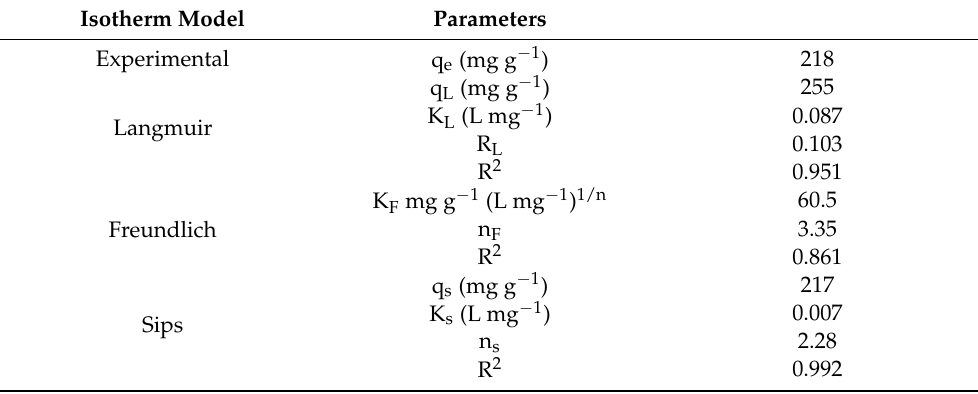
Figure 9. Adsorption isotherm fittings for Langmuir, Freundlich and Sips isotherm models for MB adsorption on CXTi synthesised in this study. Table 2. Parameters for MB adsorption at equilibrium computed from Langmuir, Freundlich and Sips isotherm model